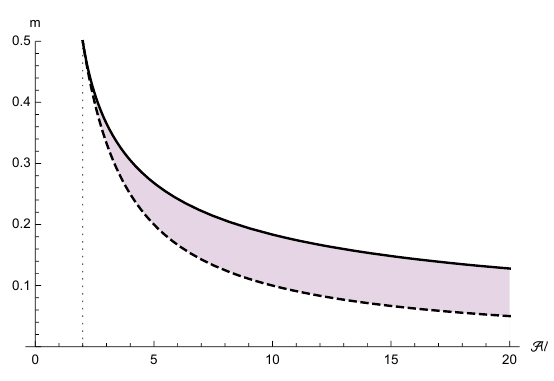
Figure 20 . The parameter space of the I rapid,C solution (shaded